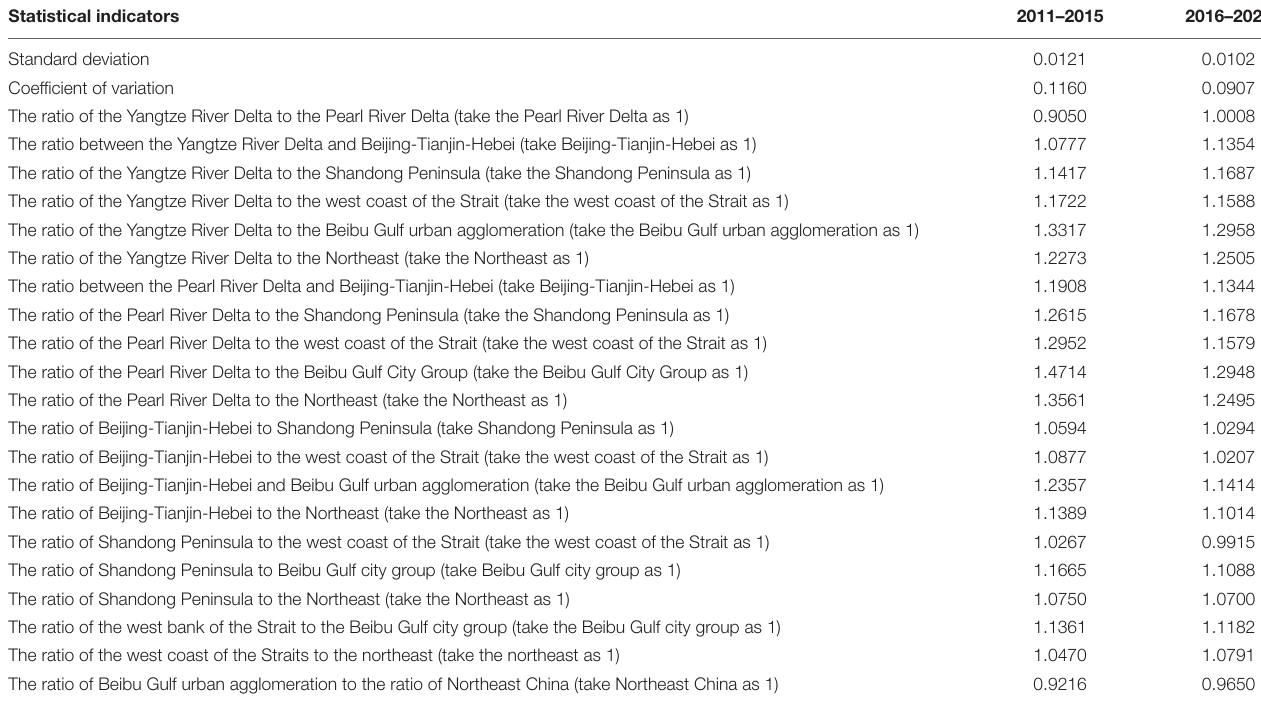
FIGURE 4 | Social development level of each indicator in the eastern region during 2016–2020. TABLE 8 | Indicators related to the gap in social development level among urban agglomerations in eastern China. Statistical